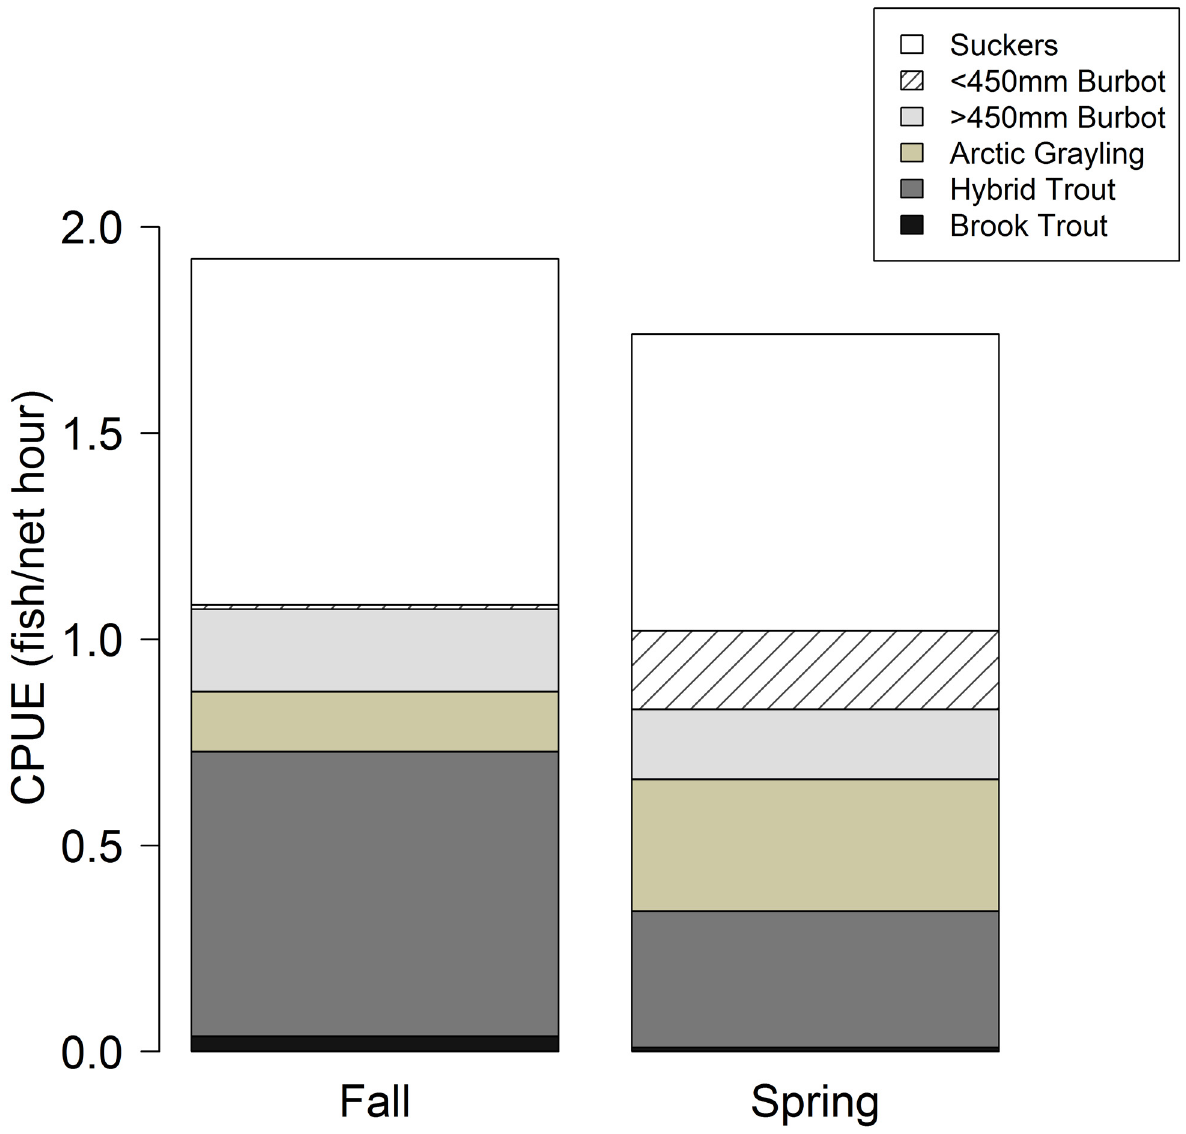
Fig 1. Standardized mean catch-per-unit-effort (CPUE) from the fish community during spring and fall, 2011 – 2012, Upper Lake, Red Rock Lakes National Wildlife Refuge, Montana, USA.